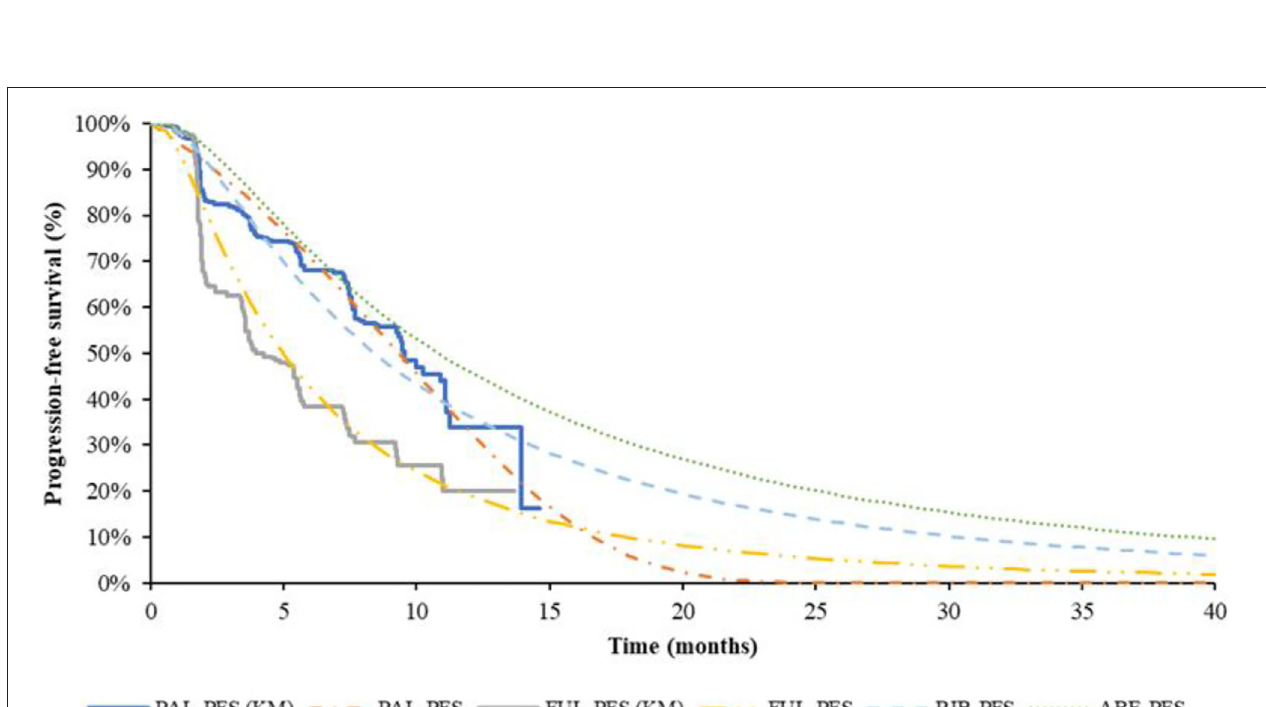
FIGURE 2 | K-M curve and parametric survival distributions for PFS. PFS, progression-free survival; ABE, abemaciclib; RIB, ribociclib; PAL, palbociclib; FUL, fulvestrant.